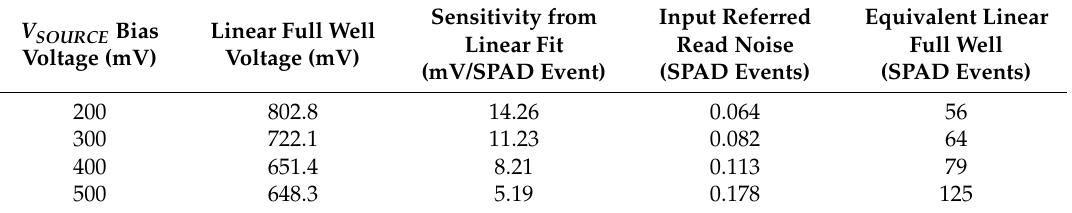
Table 1. Photon counting performance of 320 ˆ 240 SPAD-based image sensor